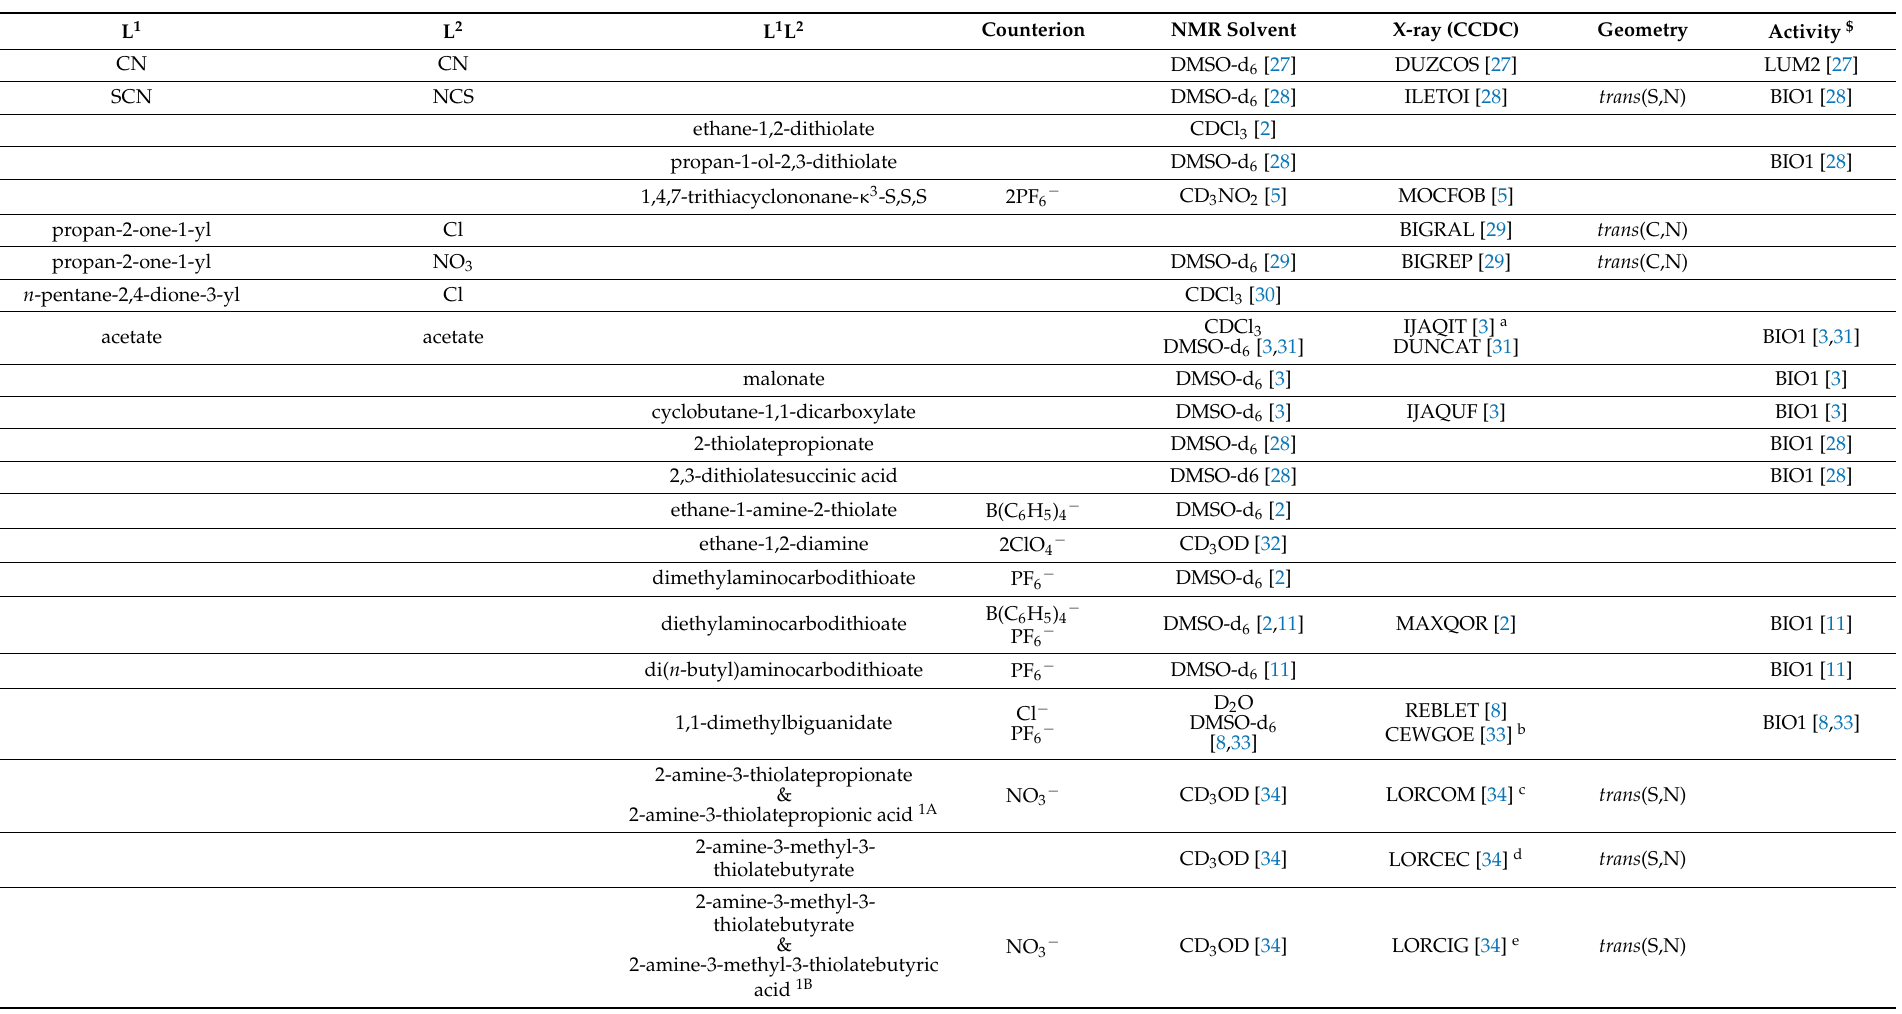
Table 2. NMR and/or X-ray studied [Au(2ppy*)L 1 L 2 ] (in particular, [Au(2ppy*)L 2 ]) and [Au(2ppy*)(L 1 L 2 )] (in particular, [Au(2ppy*)(LL)]) compounds (L 1 , L 2